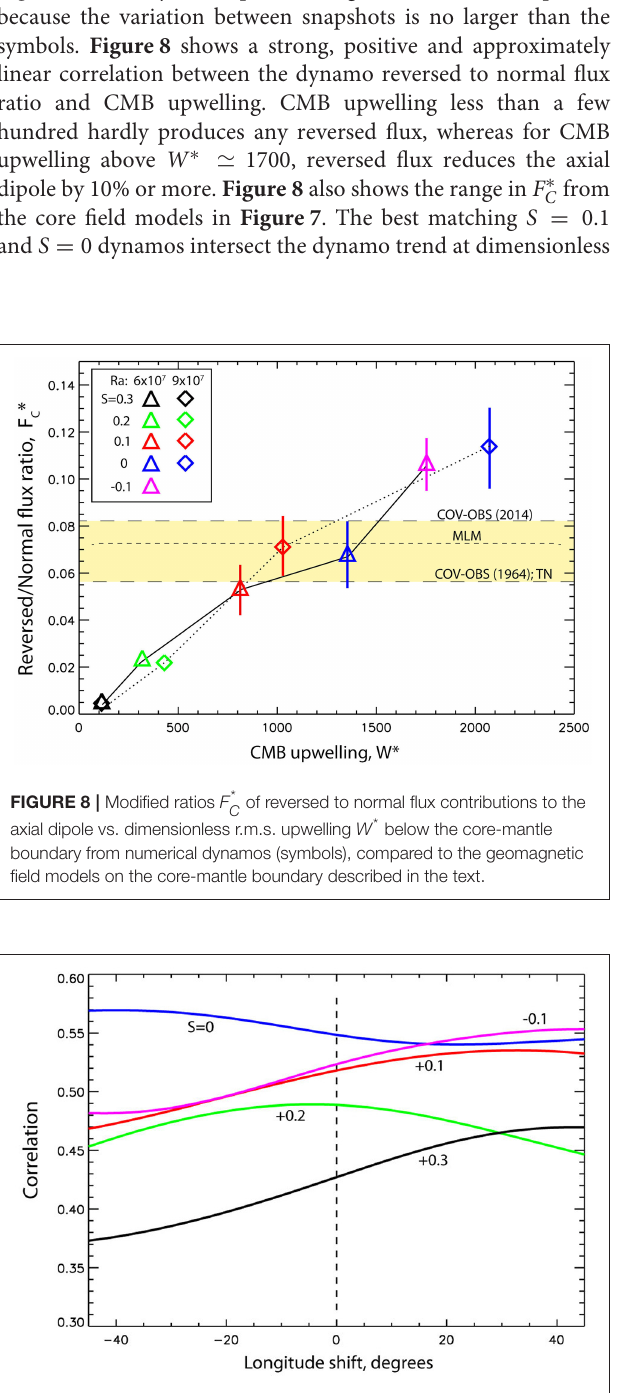
FIGURE 9 | B r cos( θ ) cross correlations of the 1840-2014 time average COV-OBS CMB geomagnetic field model vs. numerical dynamo time averages at Ra 6 10 7 , for various stratification parameters S = ×